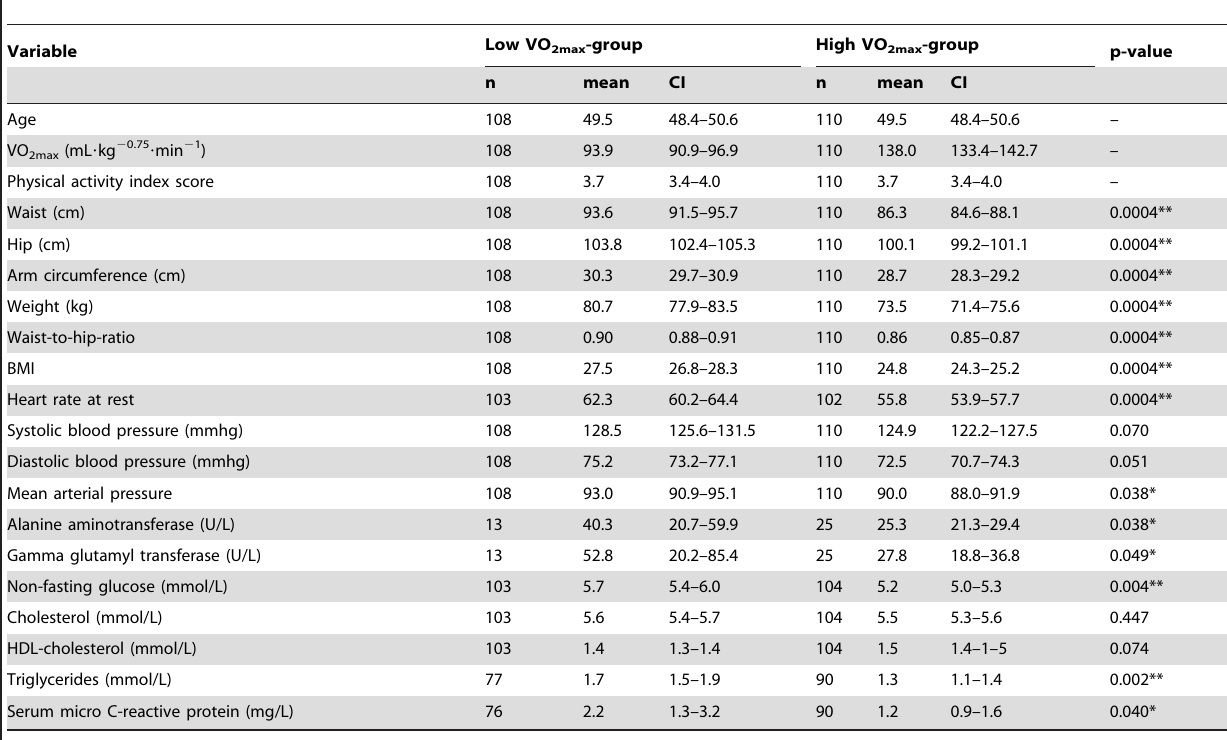
Table 1. A statistical overview of the participants in this study.